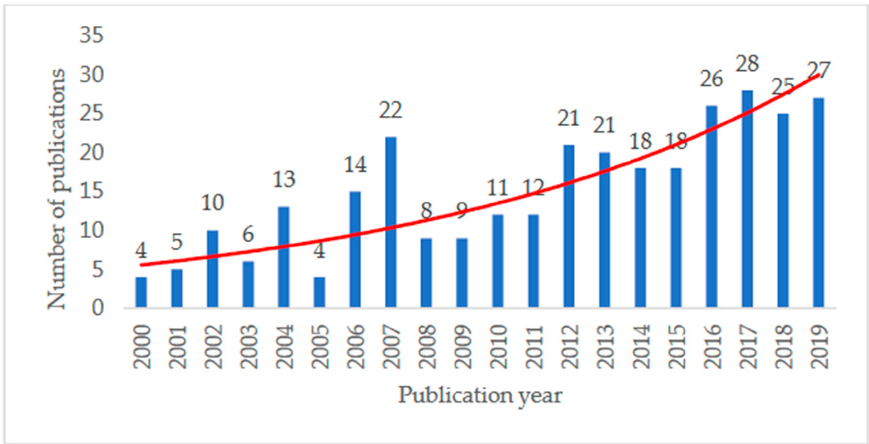
Figure 4. The number of annual publications between 2000 and 2019.